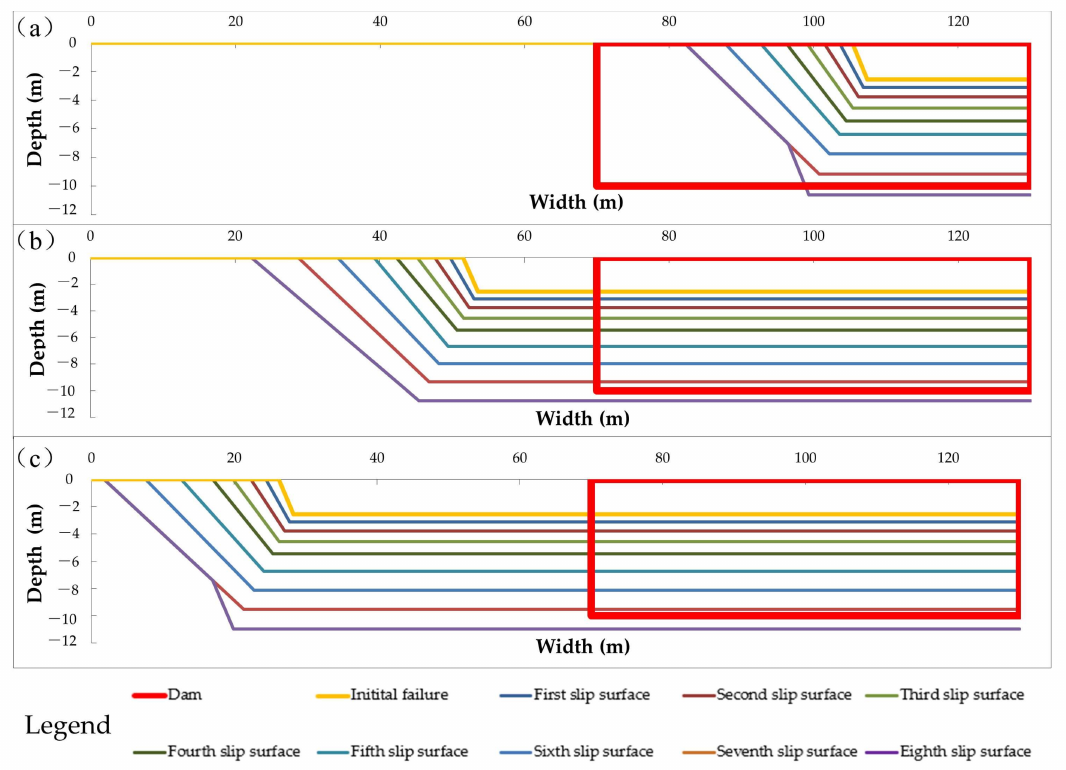
Figure 9. Slip surface during the development of the breach under three scenarios: ( a ) scenario 1; ( b ) scenario 2; ( c ) scenario 3.